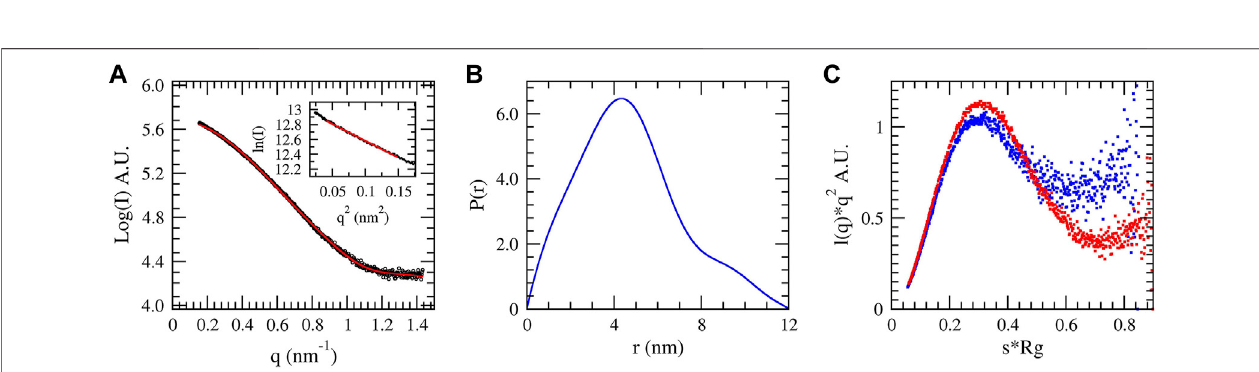
FIGURE 8 | Small-angle X-ray scattering of the complex DM64-myotoxin II in solution. (A) Theoretical (red) and experimental (blue) scattering curves of the complex. The Guinier region is shown in the inset. (B) Pair distribution function P(r) of the complex. (C) Normalized Kratky plot obtained for DM64-myotoxin II complex (blue dots) and free DM64 (red